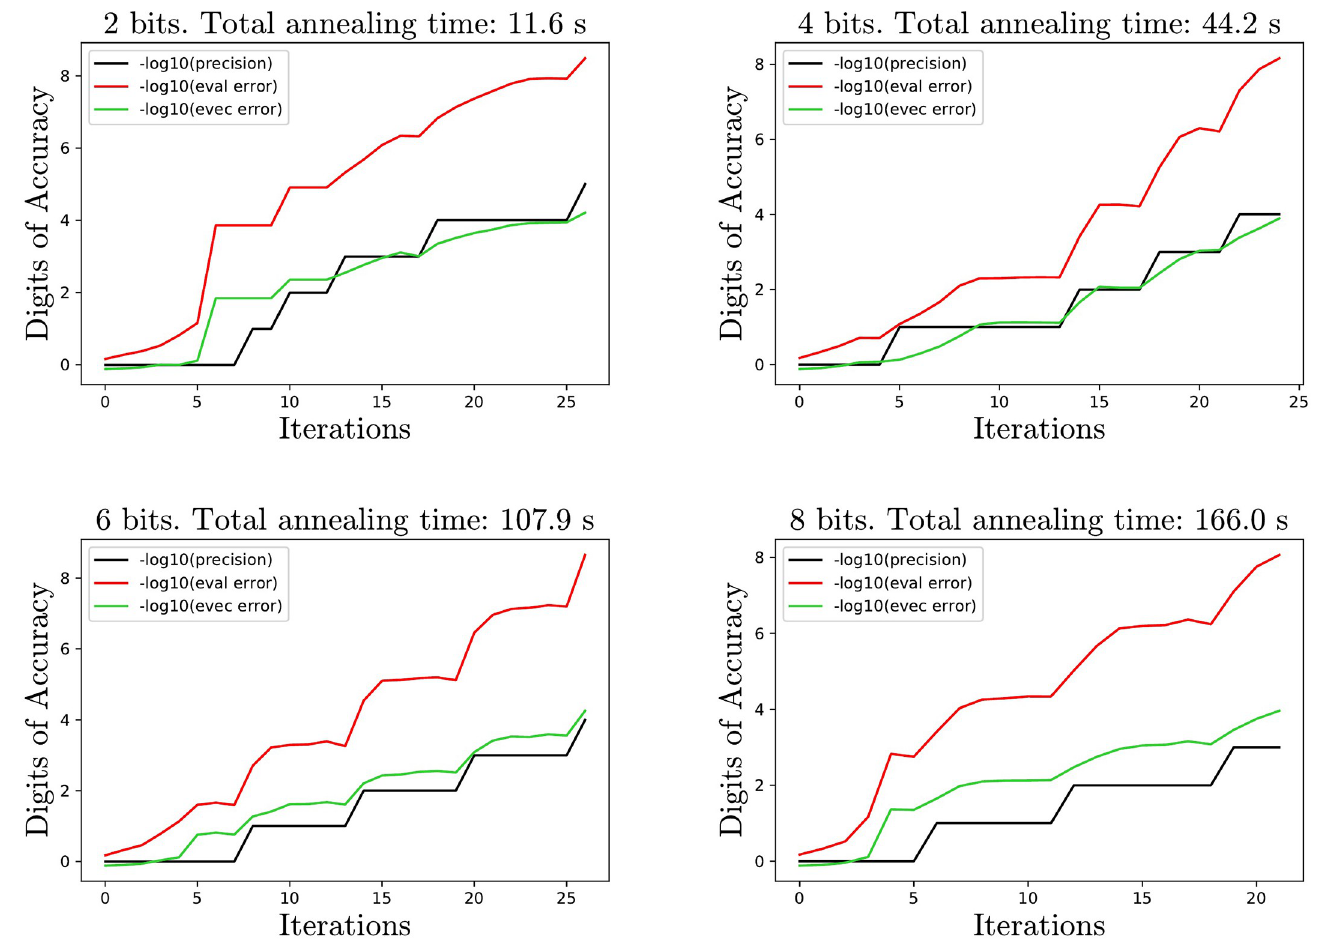
Fig 1. Digits of accuracy plotted against number of iterations. Total annealing time is the total amount of time the algorithm spends on performing SA, since SA dominates the cost of the method. Evec error is the distance of the computed vector from the true unit eigenvector. Precision refers to the scaling applied to the discretized cube at each iteration. The initial guess phase corresponds to a precision of 1. Observe that whenever the error increases, the algorithm responds by increasing the precision, which often gives large accuracy gains within the subsequent 2-3